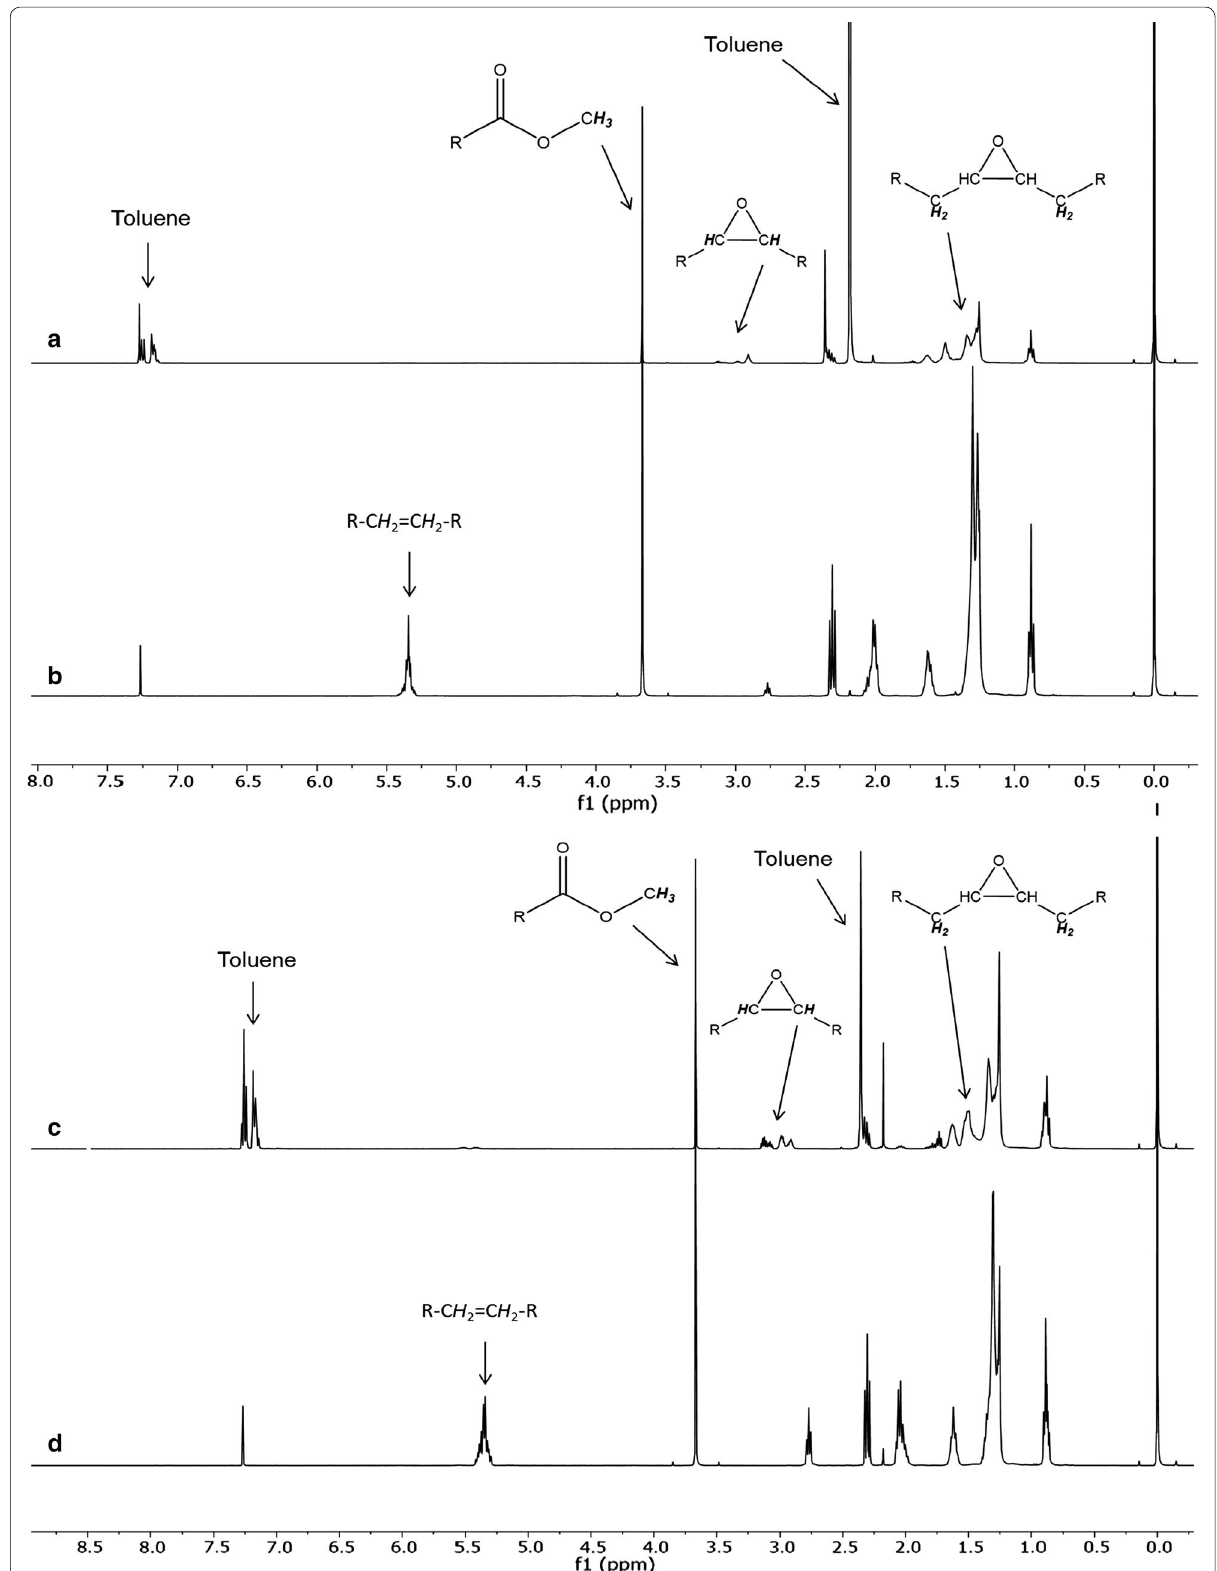
Fig. 1 1 H‑NMR spectrum of a avocado epoxide, b FAME avocado, c grapeseed epoxide, d FAME